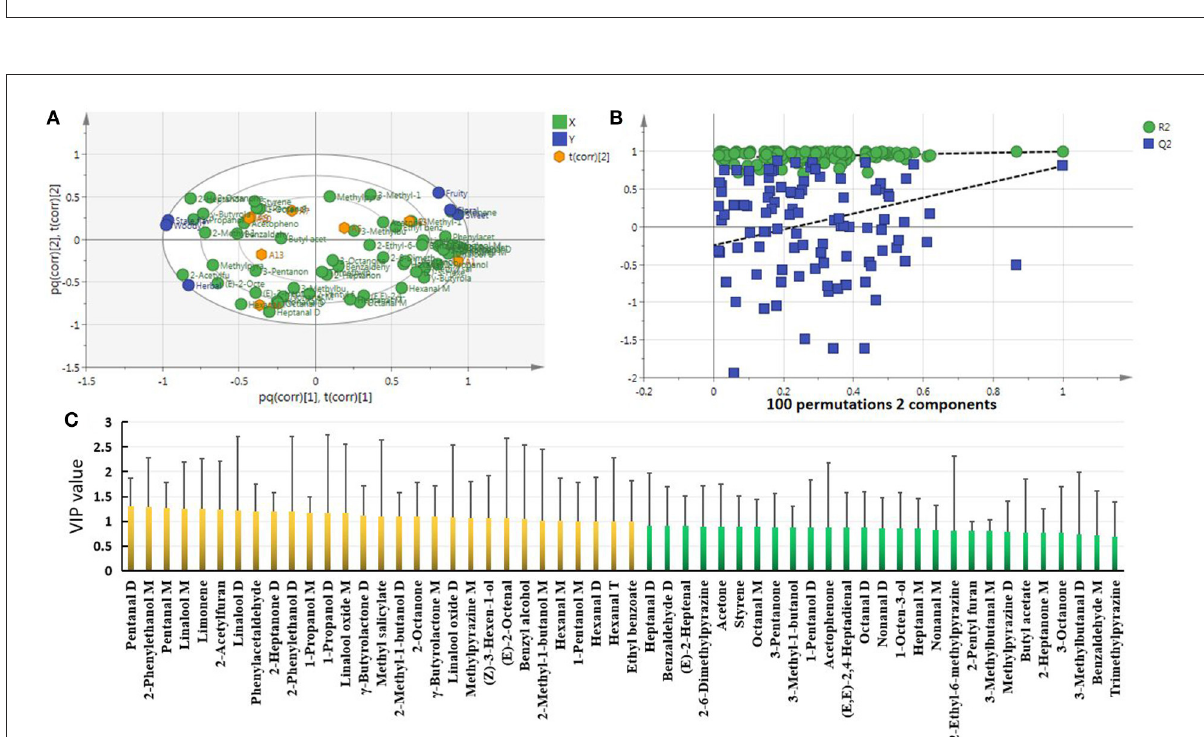
FIGURE4 Characteristic differential VOCs of CWT in different storage years. (A) OPLS-DA model. R 2 X = 0.999, R 2 Y = 0.998, Q 2 = 0.862. (B) Cross validation of OPLS-DA model. (C) Rising sun chart and molecular formula of characteristic differential VOCs.